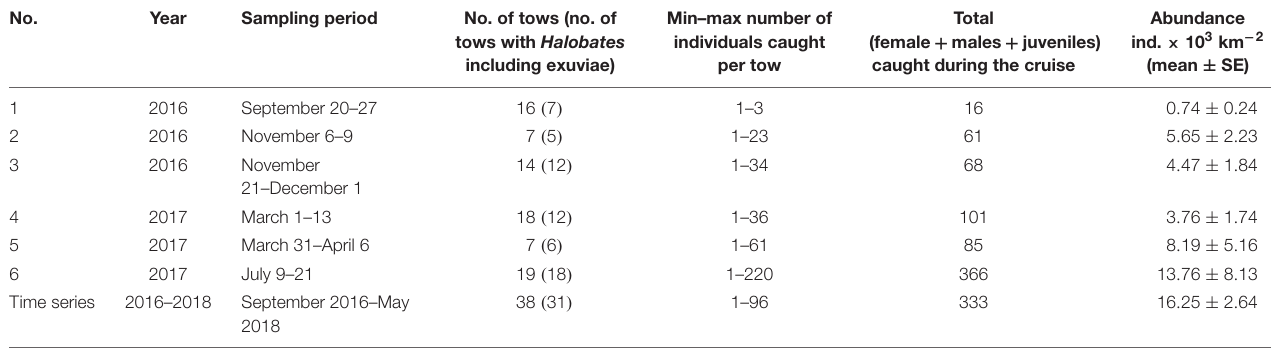
TABLE 1 | Overview of neuston sampling in the Red Sea during 2016–2018.